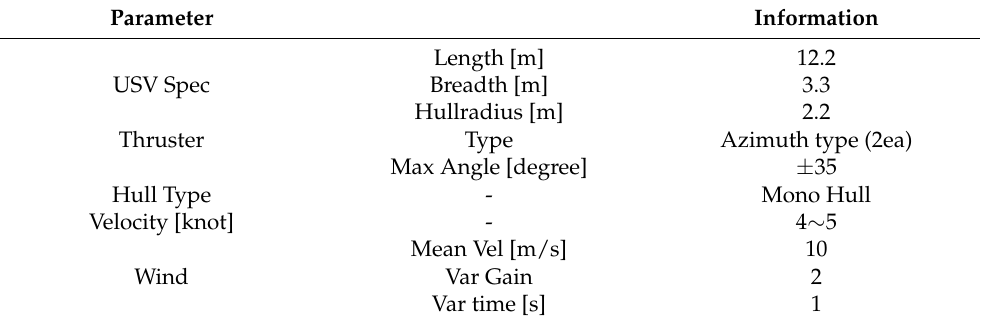
Table 1. Main specifications of the USV simulation